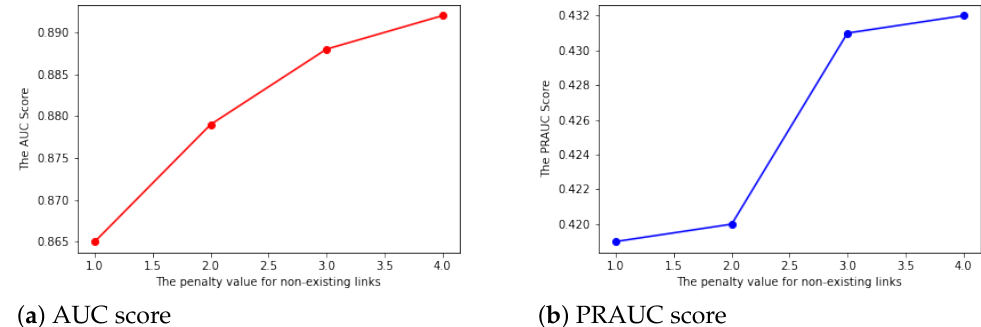
Figure 3. The evaluation metrics with different penalty scores. In ( a , b ), we use the window size l = 10 and 1-hop neighborhood GCN units. We set the penalty from 1 to 4, and the performance of AUC and PRAUC scores are shown in ( a , b ).